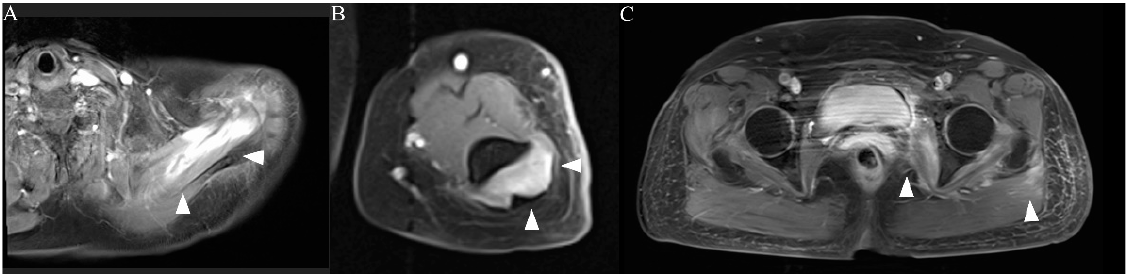
Figure 3. MRI of the extremities (post-contrast T1 images). Only the left supraspinatus muscle was homogeneously enhanced (( A ), arrowheads). Other affected muscles showed enhancement centered on the rim (( B and C) , arrowheads).